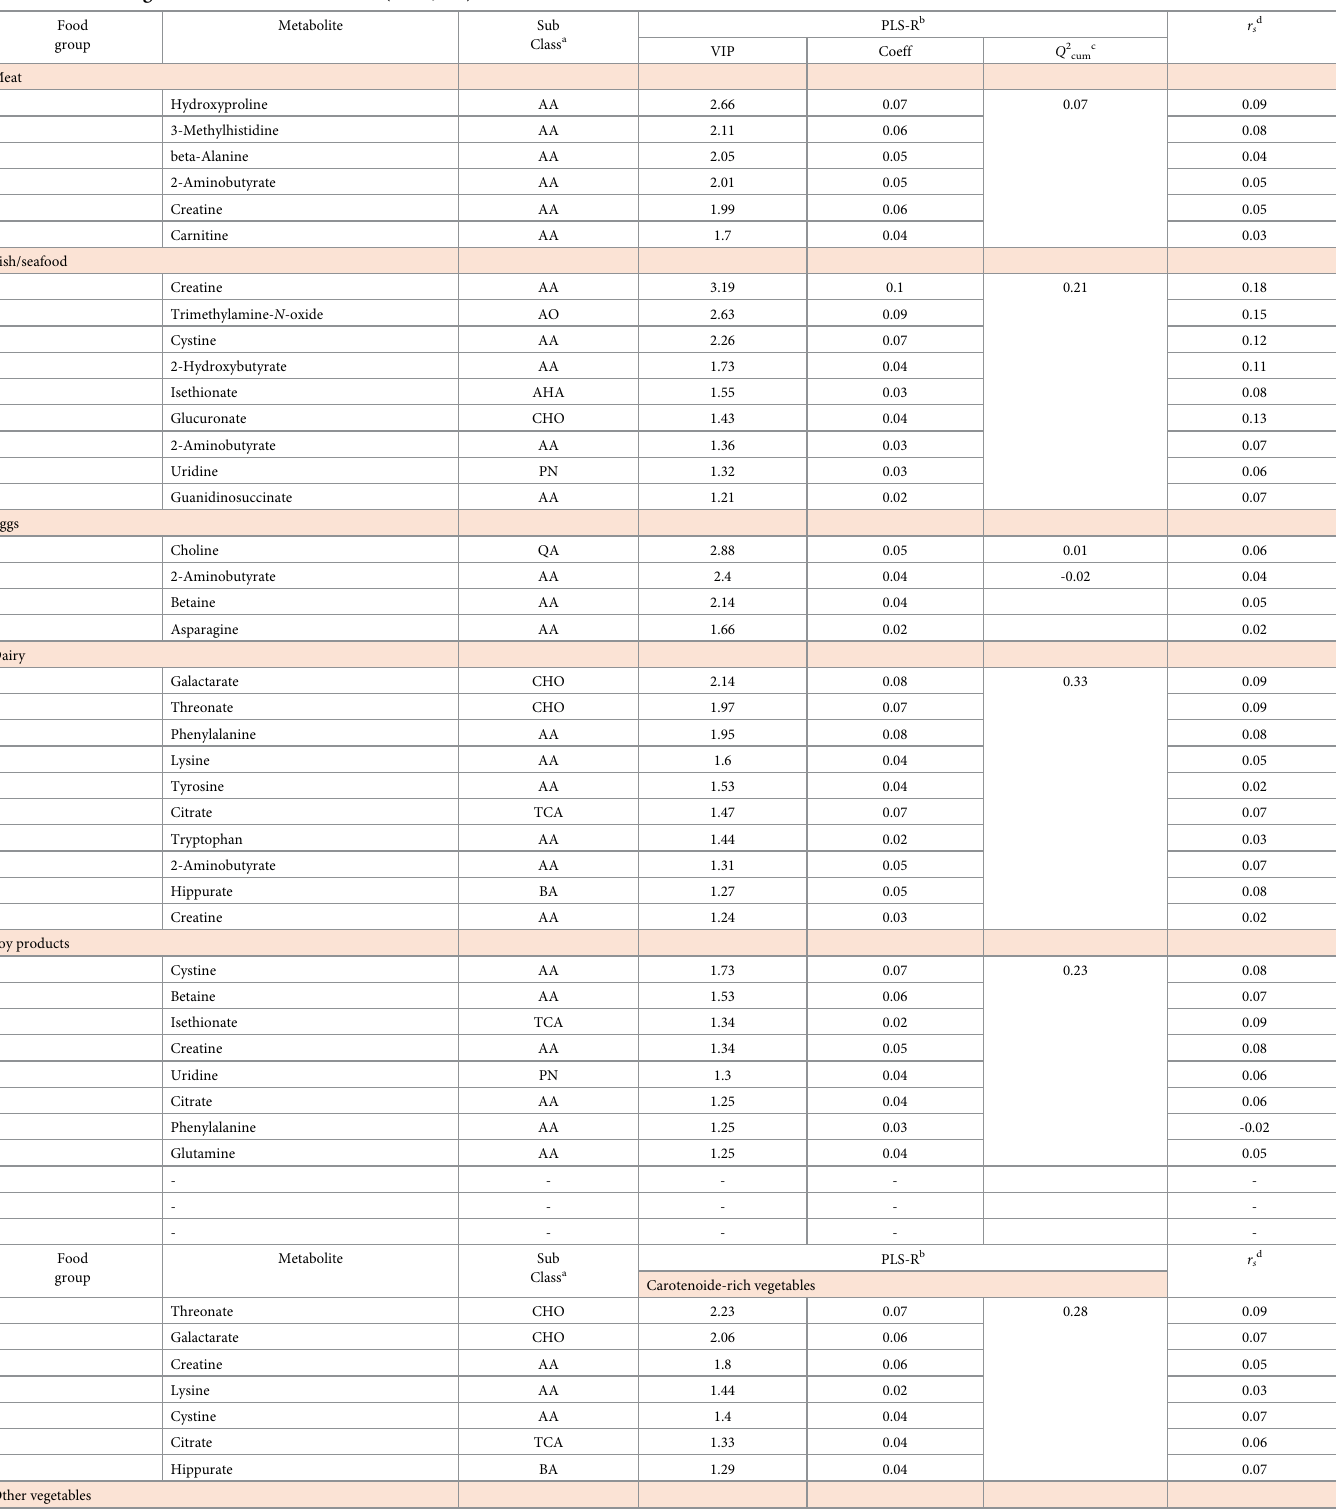
Table 3. Promising food biomarker candidates (n = 7,012). Food group